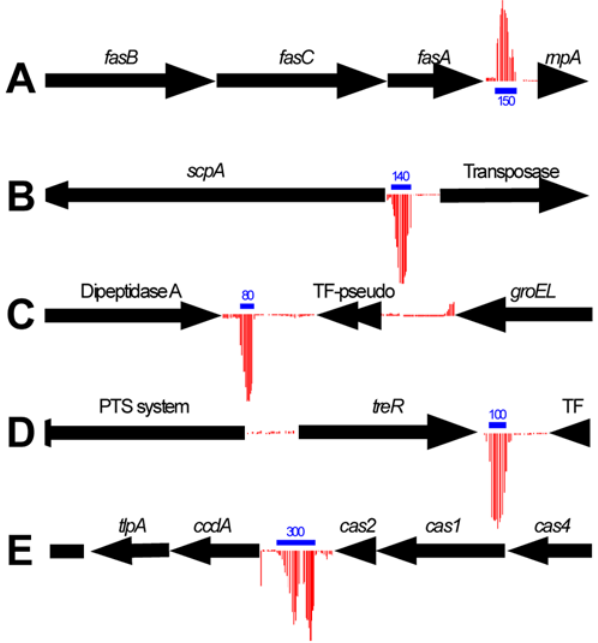
Figure 1. Representative candidate small RNA molecules identified by tiling microarray. Genes are represented by black arrows facing the direction of transcription. Red vertical lines represent signal intensities from probes (PM-MM) tiled within intergenic regions. Red lines extending upward indicate left to right transcription, downward extending lines indicate right to left transcription. Blue horizontal bars indicate RNA length with the size in nucleotides shown. ( A ) Validation of our custom microarray as a tool to identify GAS sRNAs. The previously described FASX sRNA is located downstream of fasA (M5005_spy_0206 from the published MGAS5005 genome) and can be visualized as a distinct peak of signal intensity. ( B ) A candidate sRNA located upstream, and in the same orientation as, the C5a peptidase encoding gene scpA (M5005_spy_1715). ( C ) A candidate sRNA located downstream, and in opposite orientation to, dipeptidase A (M5005_spy_1758). ( D ) A candidate sRNA located downstream of, and in opposite orientation to, the treR gene encoding a putative repressor of the trehalose operon (M5005_spy_1785). ( E ) A clustered, regularly interspaced short palindromic repeat (CRISPR) element in GAS is transcribed in the same orientation as CRISPR-associated genes ( cas1, cas2, cas4 ;